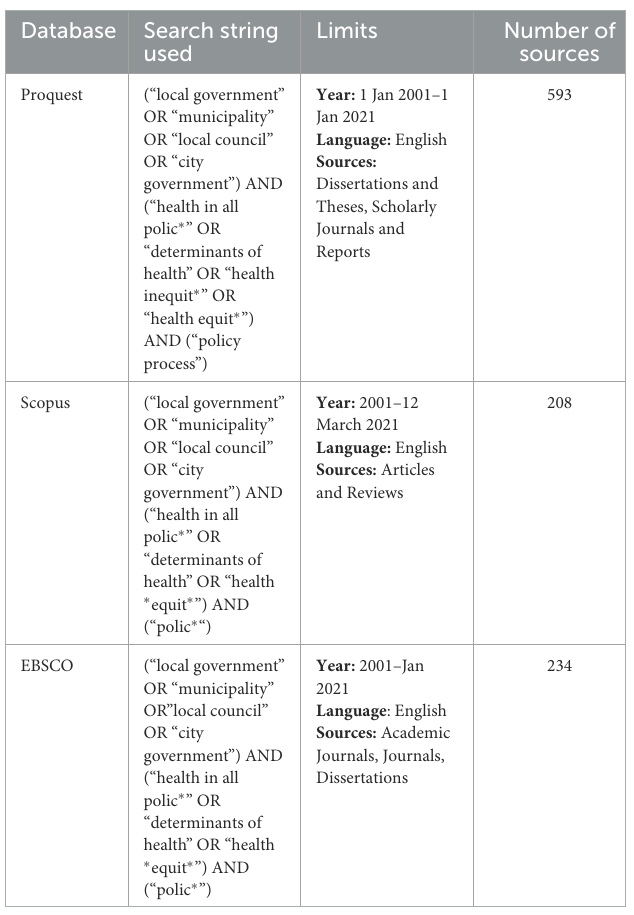
TABLE 2 Summary of inclusion and exclusion criteria applied to the sourcing of